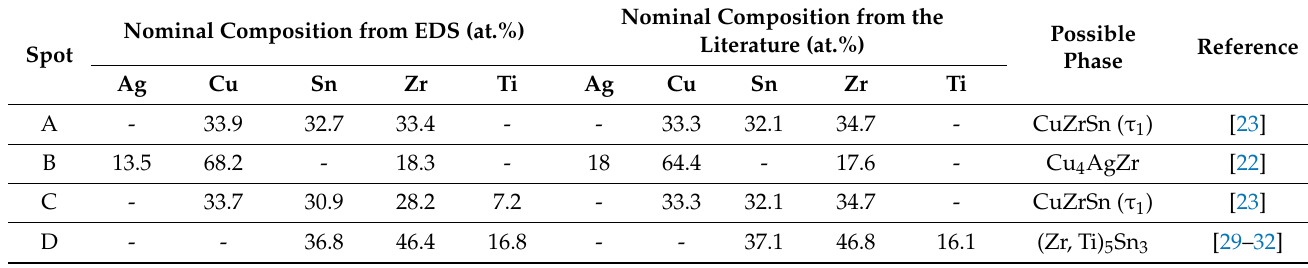
Nominal Composition from the